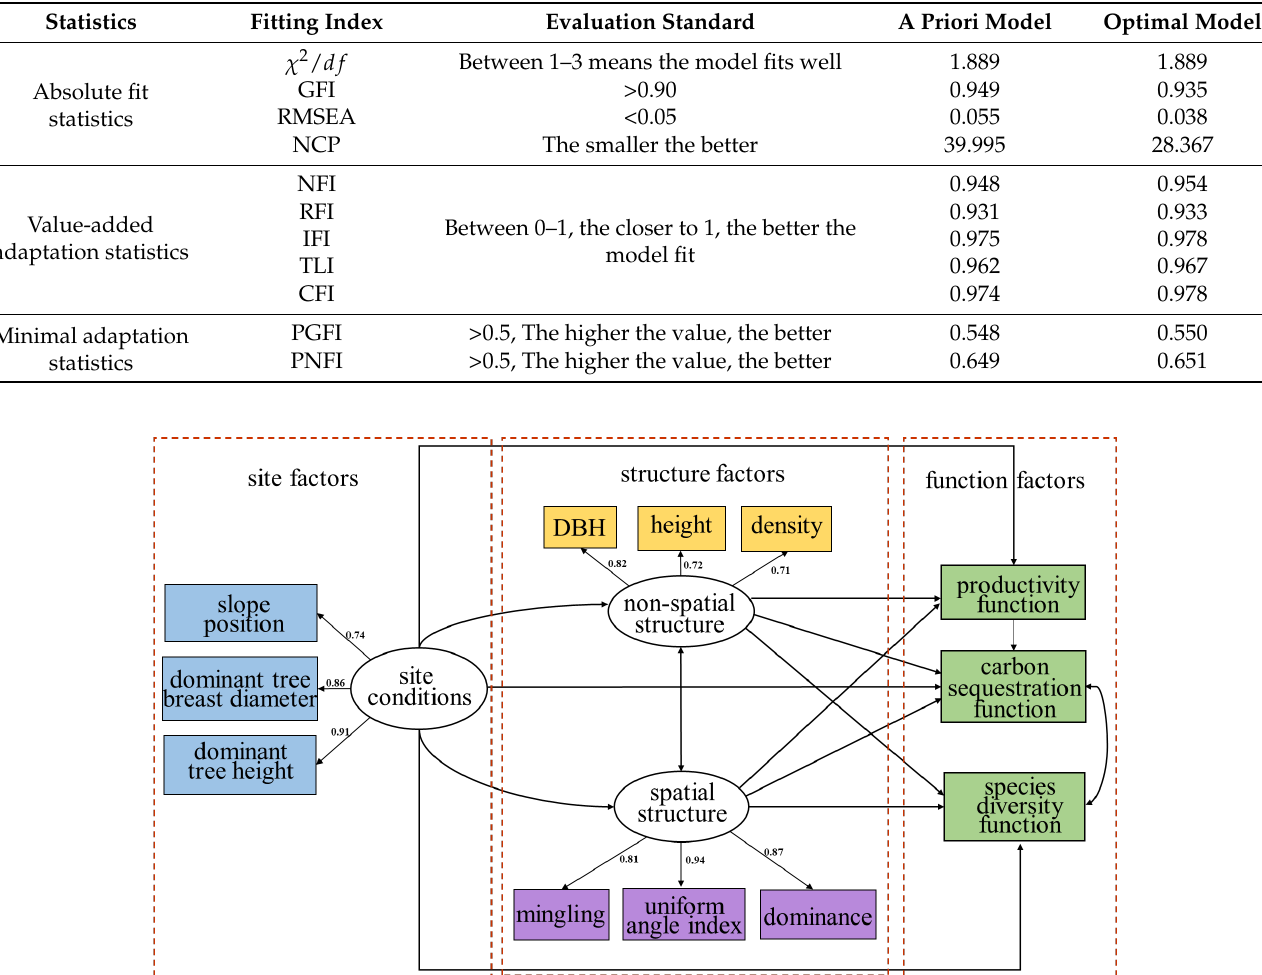
Table 1. Fitting parameters of structural equation model.